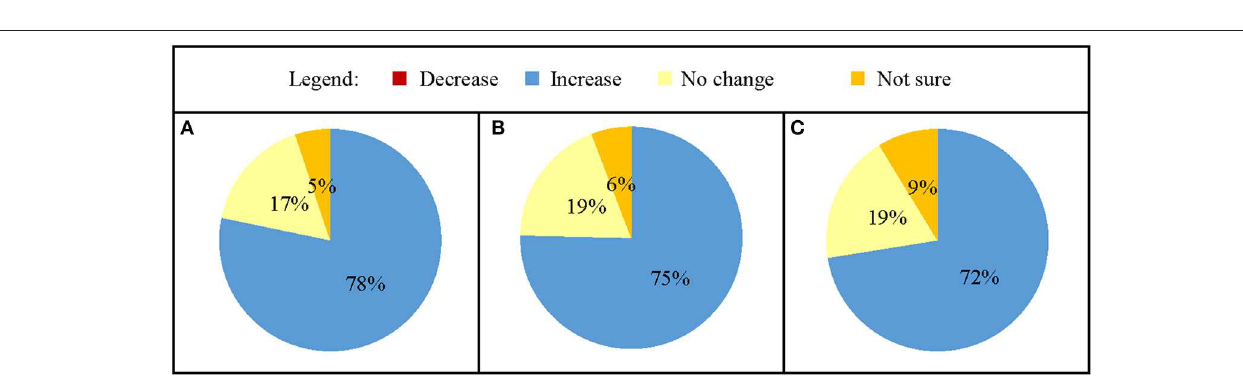
FIGURE 14 | Consumers’ perception of the environmental, economic, and nutrition information on lentils. Percentage of informants that reported they would change their current lentil consumption based on (A) environmental, (B) economic, and (C) nutritional ( p = 0.0103) information on lentils ( n =